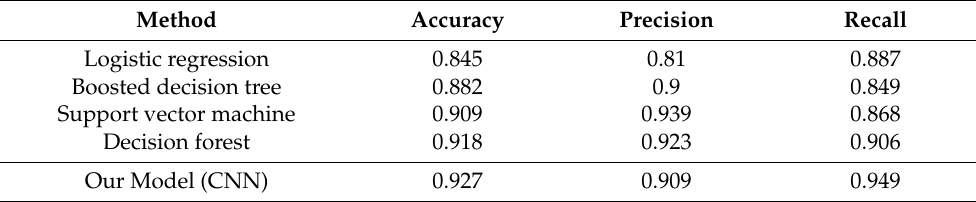
Table 2. Medication recognition algorithm accuracy.